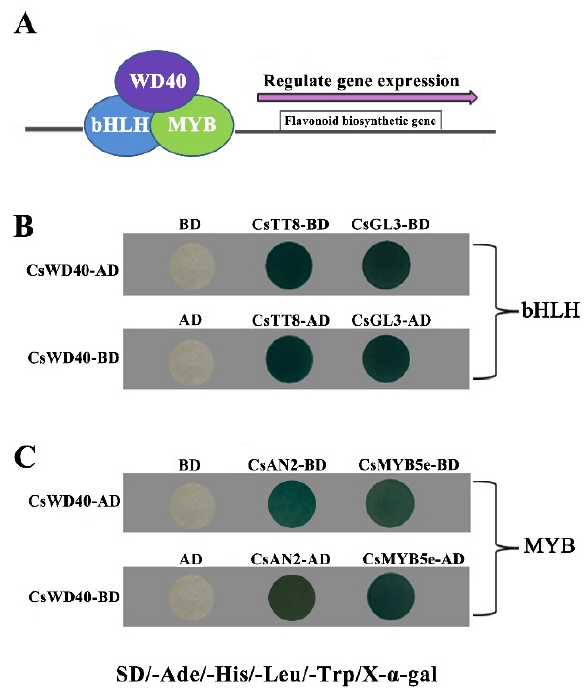
Figure 1. Protein interactions between CsWD40 and other transcript factors from tea plants by two-hybrid system. ( A ) A model pattern of the MYB–bHLH–WD40 ternary complex. ( B ) Protein–protein interactions between CsWD40 and bHLH transcript factors (CsTT8 and CsGL3) from tea plants by two-hybrid system. ( C ) Protein–protein interactions between Cs WD40 and MYB transcript factors (CsAN2 and CsMYB5e) from tea plants by two-hybrid system.